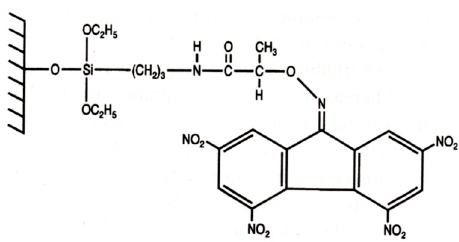
Figure 19. Structure of ( R )-( − )-2-(2,4,5,7-tetranitro-9-fluorenylideneamino-oxy)propionic acid (TAPA) bonded to silica gel [4,84].